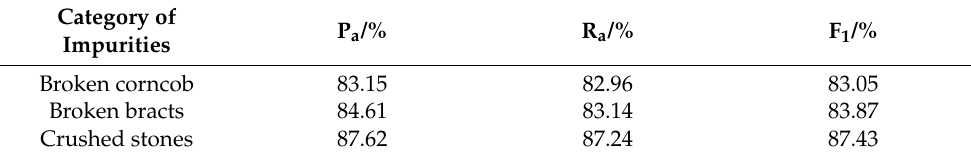
Table 1. Quantitative evaluation statistical results of impurities identification. Category